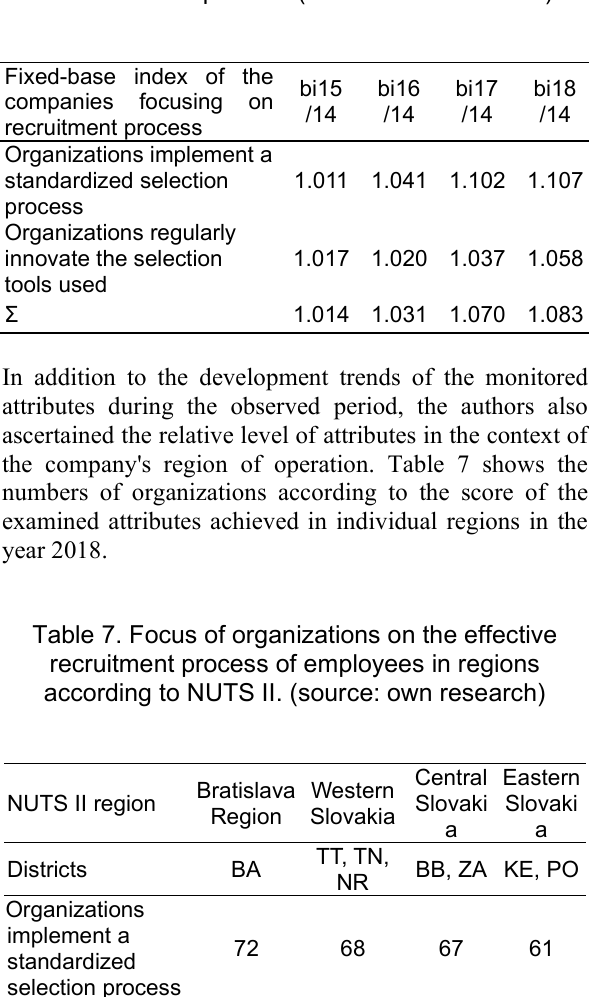
Table 6. Fixed-base index of the companies focusing